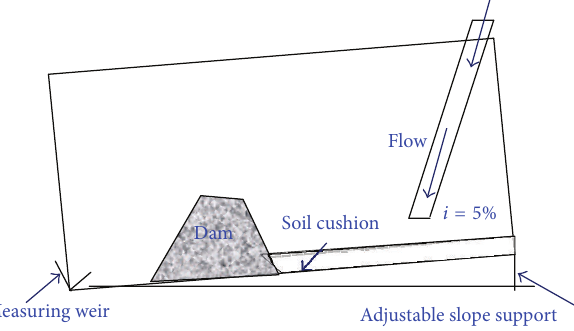
Figure 2: Schematic diagram of the experimental